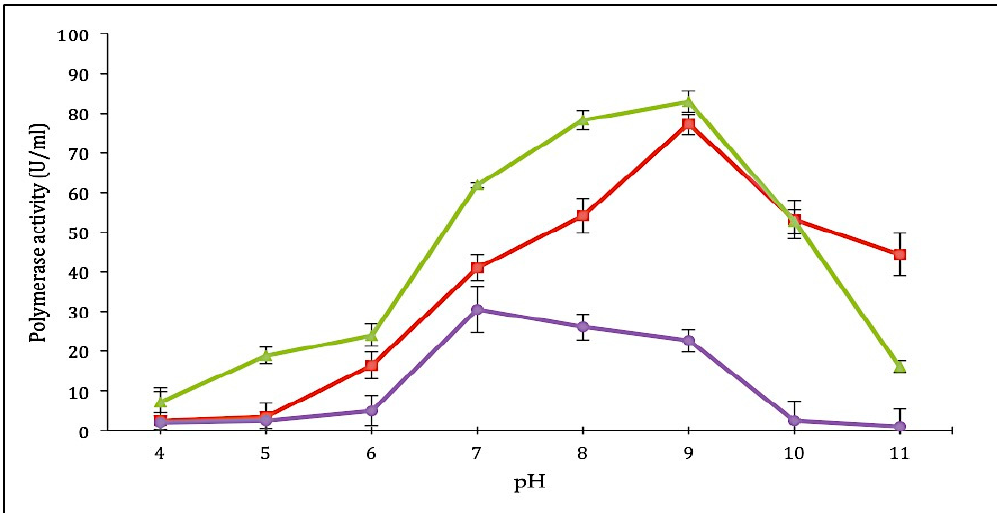
Figure 5. pH profile of SK72 DNA polymerase and its variants. Symbols represent the enzyme variants; SK72 (filled square), SK72-Exo (filled triangle), and SK72-Exo2 (filled circle). The optimal pH was determined by measuring the enzyme activity in di ff erent bu ff er systems ranging from pH 4 to 11. The error bars represent standard deviation ( n = 3). The absence of the bar indicates that the error is smaller than the